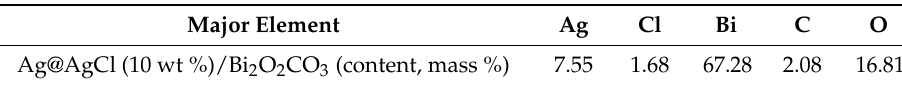
Table 2. The major elemental content of photocatalysts.